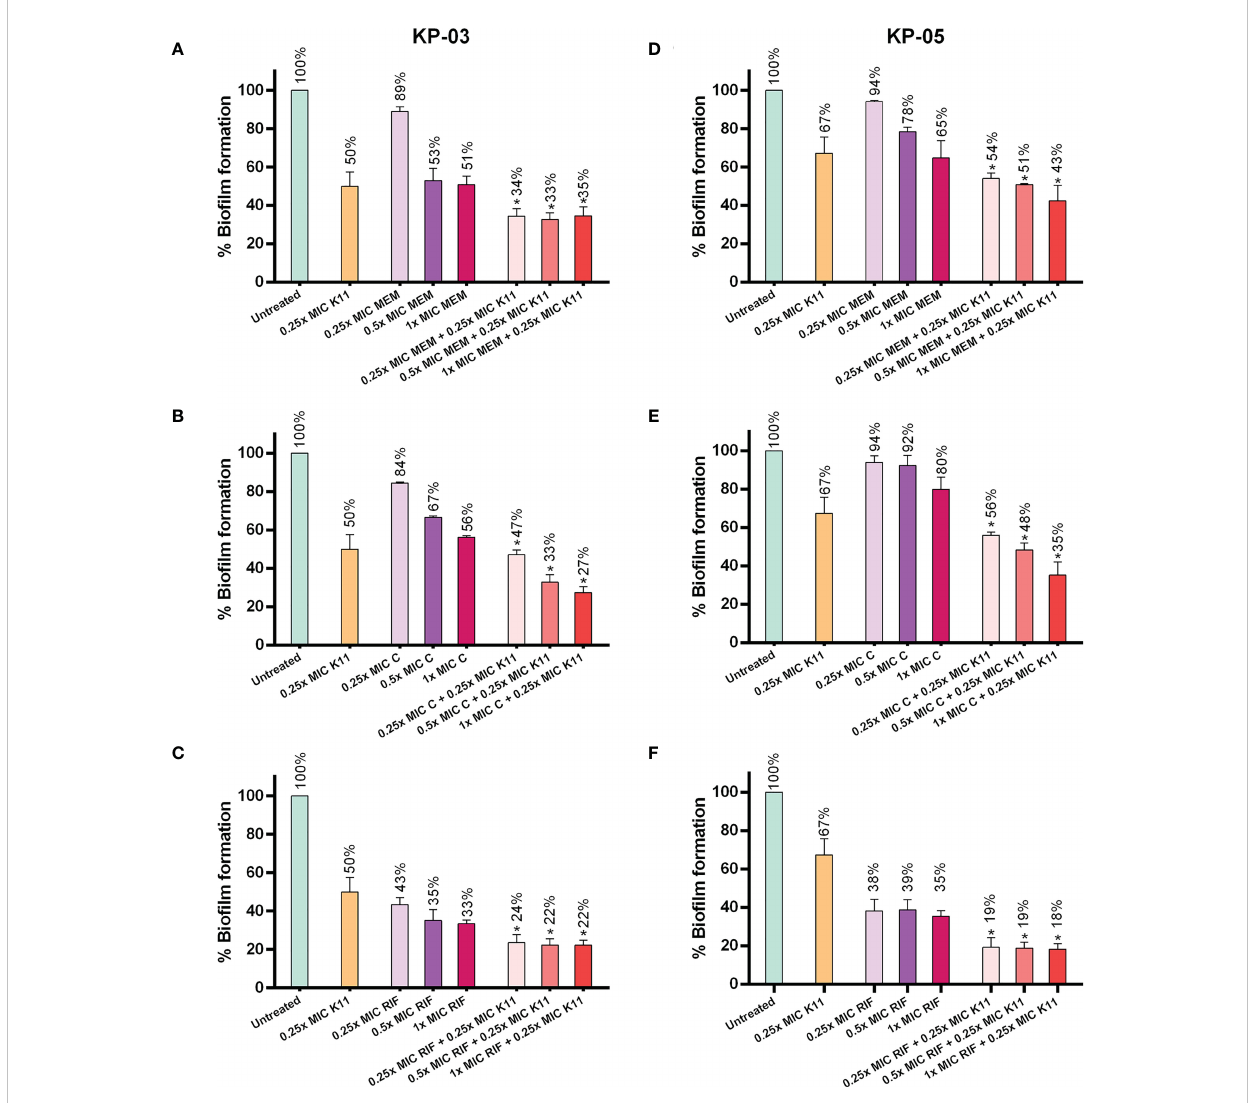
FIGURE 3 Effects of K11 against MDR/XDR K. pneumoniae bio fi lm when administered in combination with conventional antibiotics. Two representatives of MDR/XDR-strong bio fi lm producers of K. pneumoniae , KP-03 and KP-05, were tested with K11 or antibiotic alone or in the combination of K11 and antibiotics for bio fi lm-inhibiting activity. (A – C) KP-03 isolate was tested with K11 or antibiotic; meropenem (MEM), chloramphenicol (C), rifampicin (RIF) alone or in the combination of K11 and antibiotics. (D – F) KP-05 isolate was tested with K11 or antibiotic; meropenem (MEM), chloramphenicol (C), rifampicin (RIF)) alone or in the combination with K11 and antibiotics. The untreated bar indicates MDR/XDR K. pneumoniae bio fi lm without any antimicrobial agent. Crystal violet was used to determine the total biomass of the bio fi lm. The data was calculated by one-way ANOVA; *P value <0.05. Percent numbers indicate % bio fi lm